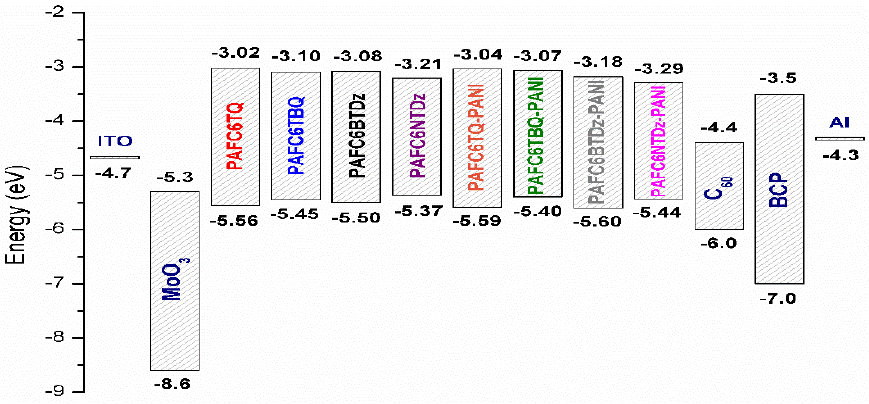
Figure 4. Device structure and HOMO and LUMO energy levels of 1D ‐ and 2D ‐ conjugated copolymers.